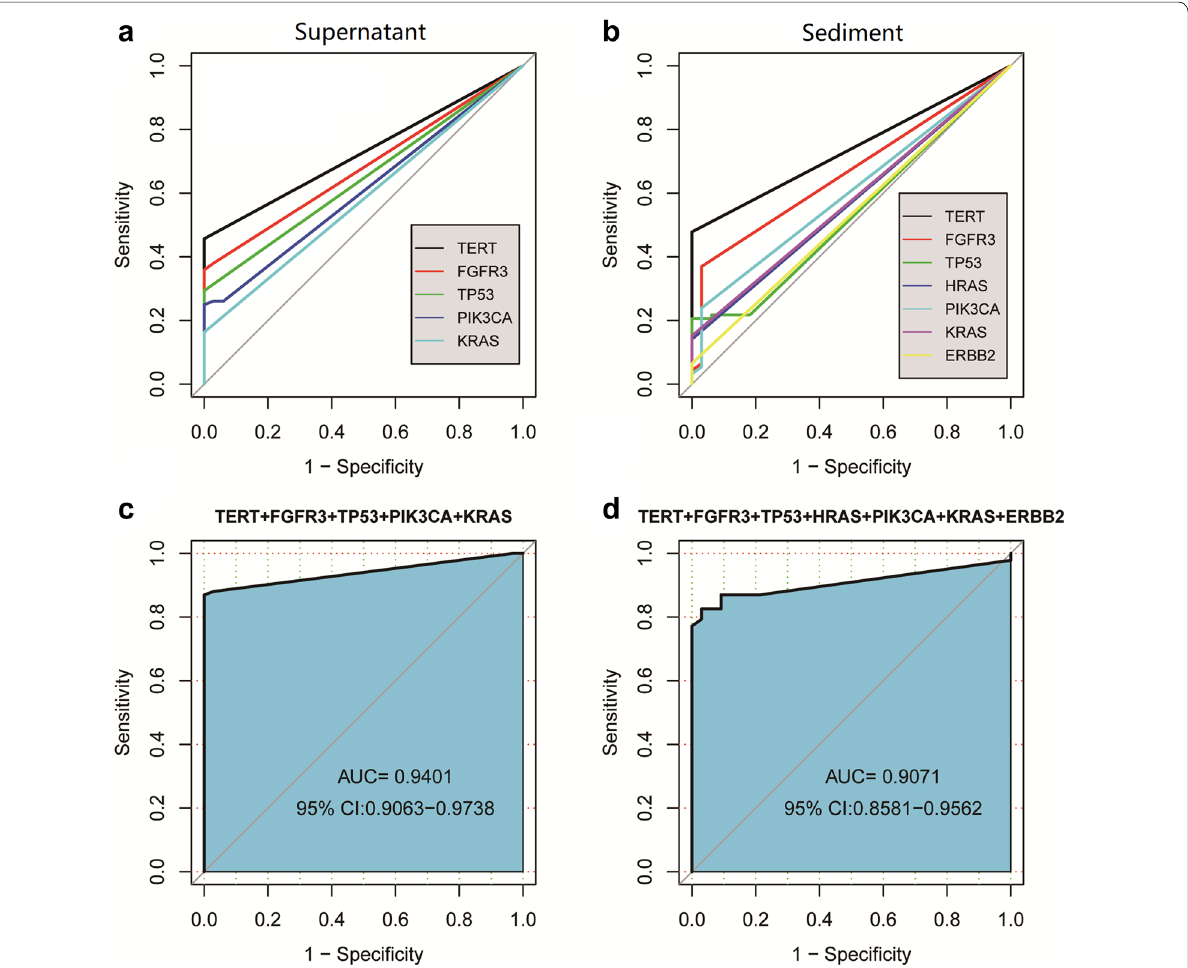
Fig. 6 Diagnostic models based on mutations of a single gene or gene combination found in all 125 urine supernatant or urine sediment samples for discriminating cancer from controls. a Individual AUCs based on the five genes TERT , FGFR3 , TP53 , PIK3CA , and KRAS assayed in urine supernatant; b individual AUCs based on the seven genes TERT , FGFR3 , TP53 , HRAS , PIK3CA , KRAS, and ERBB2 assayed in urine sediments; c , d AUCs of the five-gene and seven-gene combinations using urine supernatant and sediments,